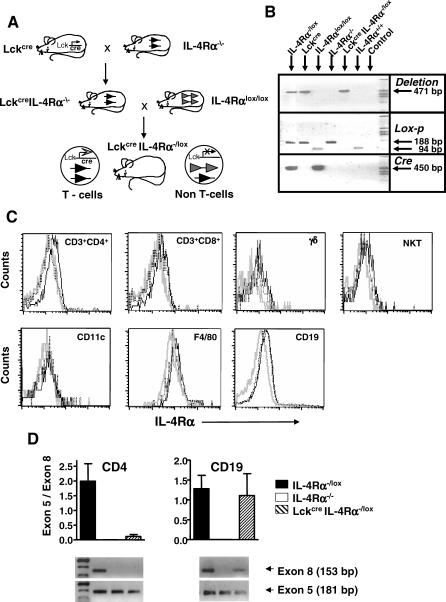
Generation of LckcreIL-4Rα−/lox Mice(A) Mouse breeding strategy. IL-4Rαlox/lox BALB/c mice were intercrossed with transgenic BALB/c mice expressing Cre-recombinase under control of the Lck promoter and IL-4Rα−/− BALB/c mice to generate LckcreIL-4Rα−/lox mice. The “loxed” IL-4Rα allele, gray arrows; deleted allele, black arrows.(B) Genotyping of LckcreIL-4Rα−/lox mice. The deleted IL-4Rα PCR yields a product of 471 bp, LoxP, 188 bp (loxed), and 94 bp (WT), and Cre-specific a 450-bp product.(C) Phenotypic analysis. WT (solid line), IL-4Rα−/− (gray line), and LckcreIL-4Rα−/lox BALB/c mice (dashed line) LN cells were stained for expression of IL-4Rα. T cell subsets were identified using anti-CD3, anti-CD4/CD8, or δ-TCR. B cells, anti-CD19. DCs, CD11c/I-Ad. Macrophages, F4/80/I-Ad.(D) Efficiency of IL-4Rα deletion. The ratio of IL-4Rα exon 5 and exon 8 alleles was determined by real-time PCR from genomic DNA purified from CD4+ or CD19+ cells. PCR products of amplified genomic DNA from real-time PCR reactions (75 cycles) were visualized on agarose gel. Data is representative of 2 independent experiments with triplicate values ± SD.